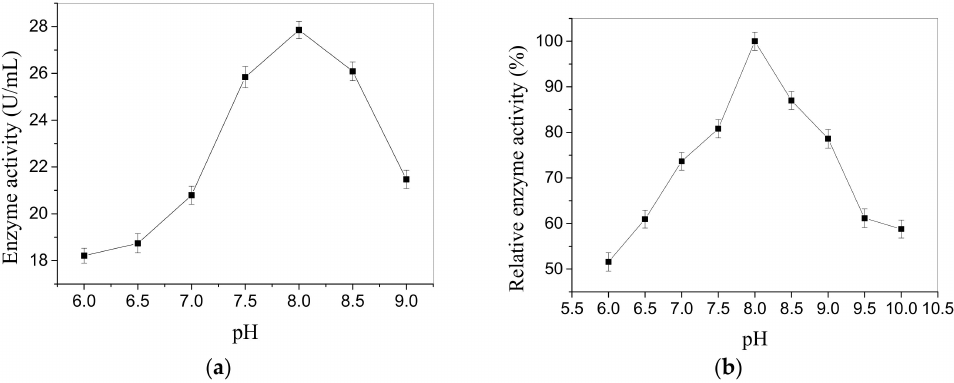
Figure 4. Influence of pH on activity of the CEP ( a ) and relative enzyme activity of CEP after 30 min incubation at pH ranging from 6.0 to 10.0 ( b ). The error bars express standard deviation of average value ( n = 3).